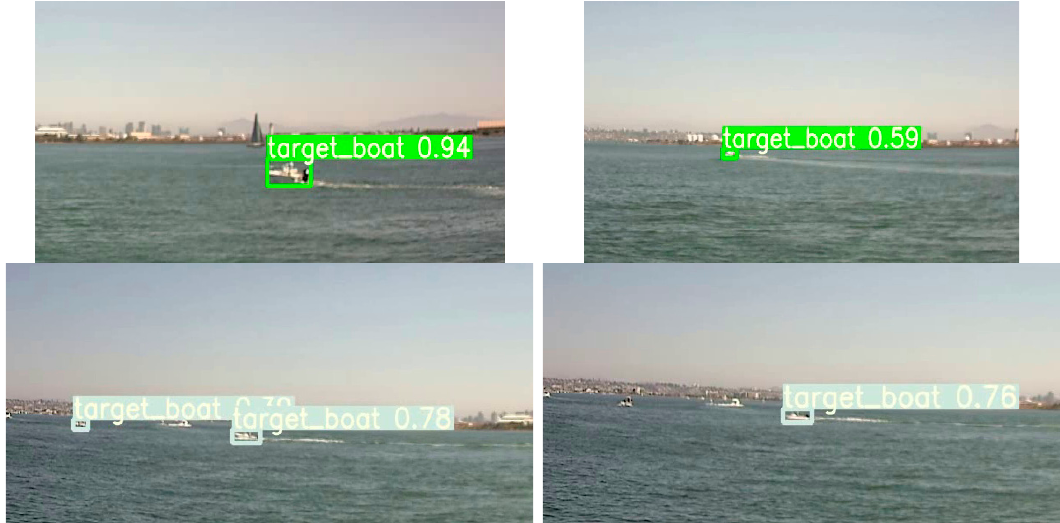
Figure 6. Temporal filter effect: ( upper left ) a positive target boat with a high confidence value, ( upper right ) a positive target boat with a medium confidence value, ( bottom left ) a smaller boat is detected incorrectly as the target boat at the left side, ( bottom right ) the incorrect label is removed after the filter process.